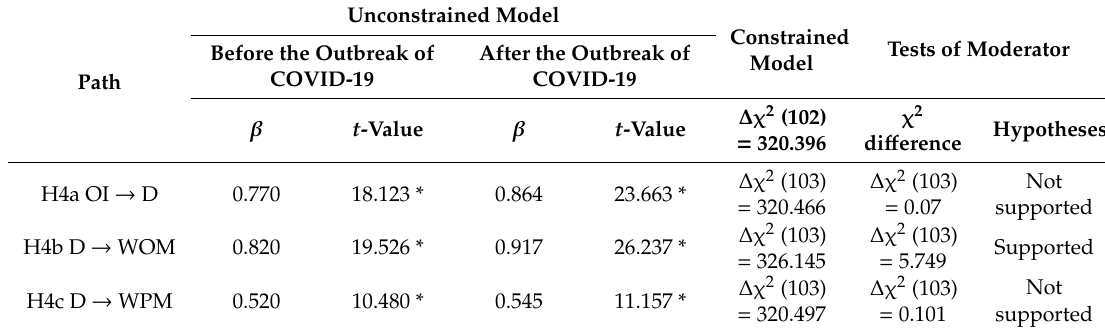
Table 5. The moderating role of the outbreak of